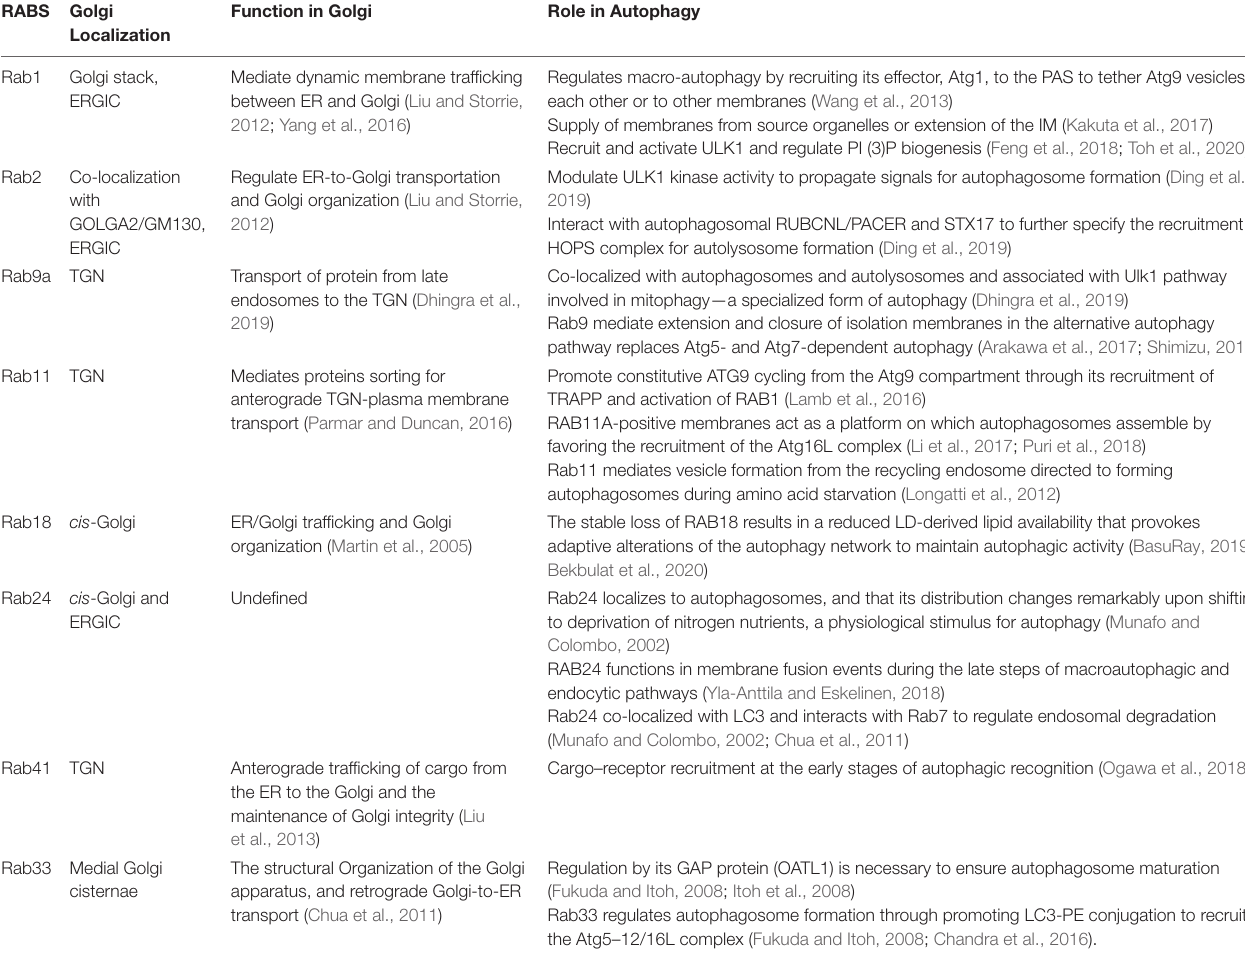
TABLE 2 | The function of Rabs in